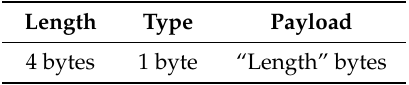
Table 3. Traffic capture interface